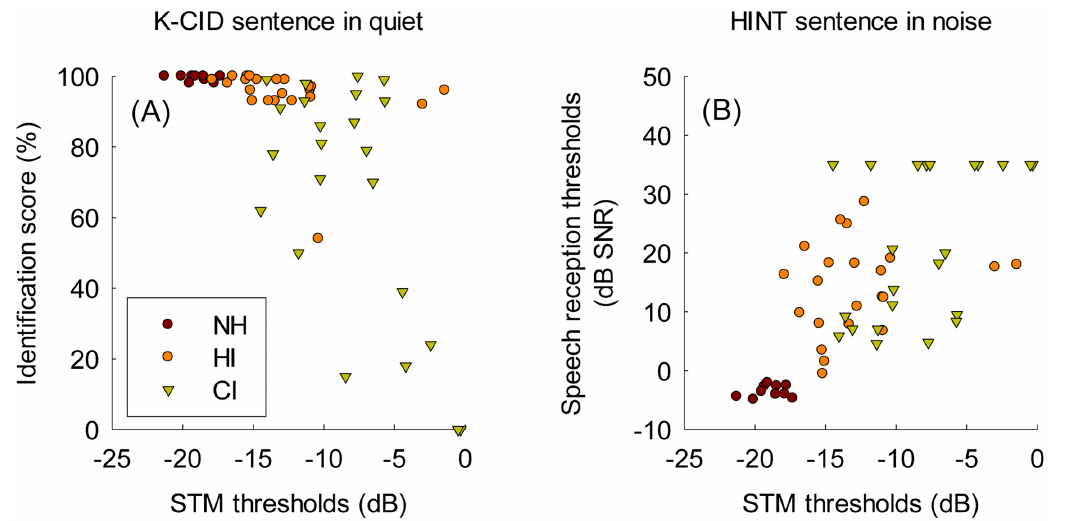
Fig 7. The relationship between mean STM detection thresholds averaged across the six different stimulus conditions and K-CID sentence recognition in quiet (A) and HINT sentence recognition in noise (B) across NH, HI, and CI subjects.